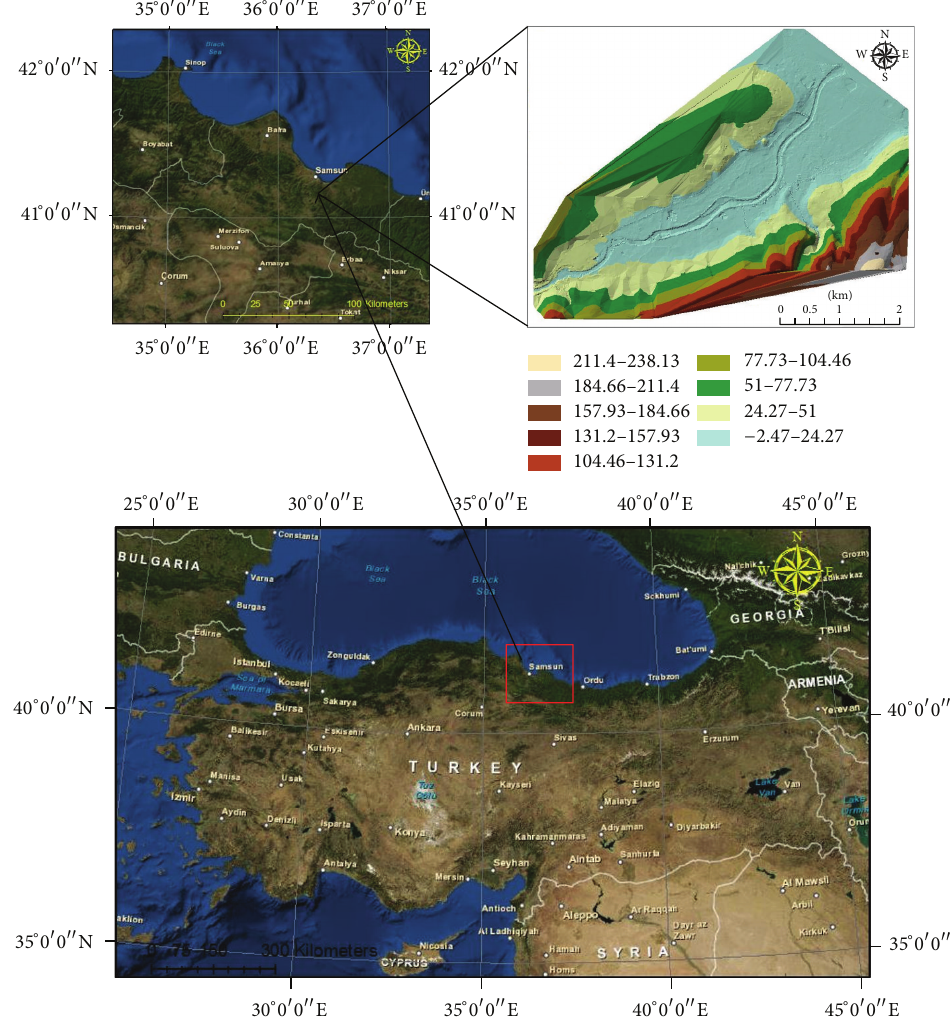
Figure 1: The location of the study area in